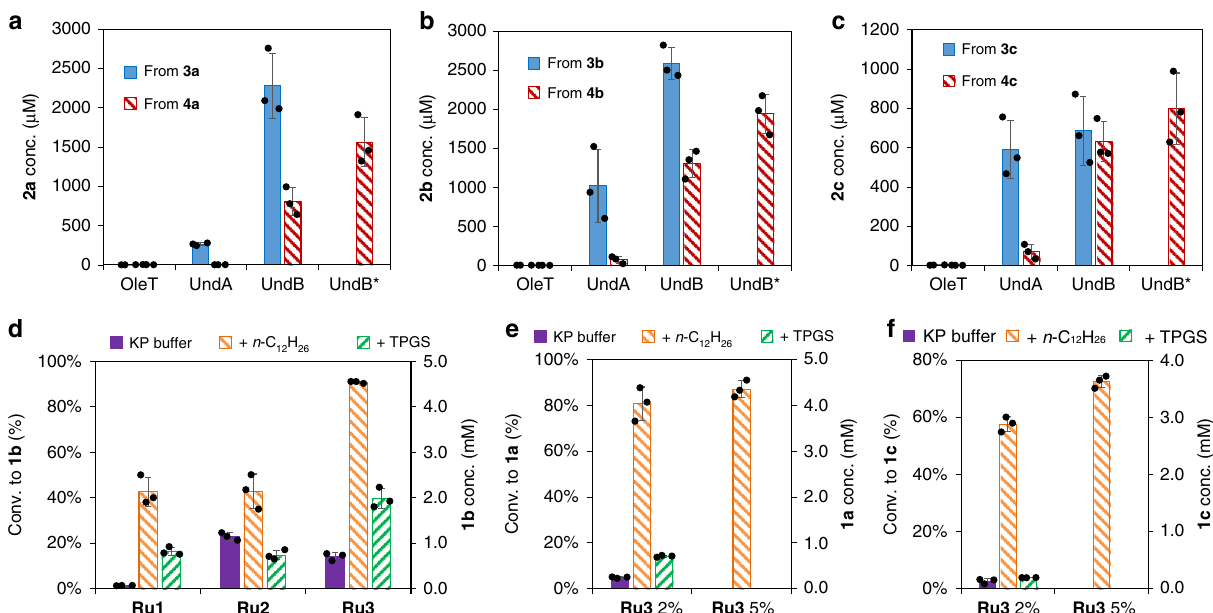
Fig. 3 Results for the (bis-)decarboxylation by decarboxylases and the RCM by Ru-based catalysts. a – c Decarboxylation of 3a-3c and 4a-4c (5 mM) to the corresponding dienes 2a-2c in the presence of E. coli cells (10 g l − 1 ) expressing OleT, UndA, or UndB in KP buffer (200 mM, pH 8.0, 2% glucose) at 30 °C for 24 h. * stands for the optimized condition in KP buffer (200 mM, pH 8.0, 1% glucose). d RCM of diene 2b (5 mM) by ruthenium catalyst Ru1-Ru3 (100 μ M) in KP buffer (200 mM, pH 8.0) with or without n -dodecane (10%) or TPGS-750-M (1%) at 30 °C for 24 h. e , f RCM of diene 2a and 2c (5 mM) by Ru3 (100 – 250 μ M) in KP buffer (200 mM, pH 8.0). Source data are provided as a Source Data fi le. Data are mean values of triplicates with error bars